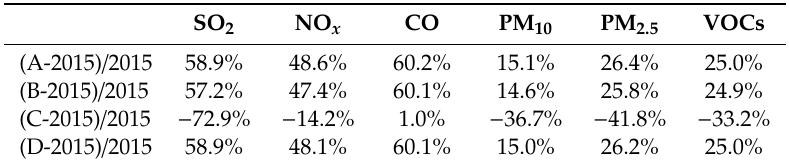
Table 1. Changes in pollutant emissions of the di ff erent scenarios in the whole city (Guangzhou) (A, B, C, and D are scenarios 2020A, 2020B, 2020C, and 2020D, respectively).